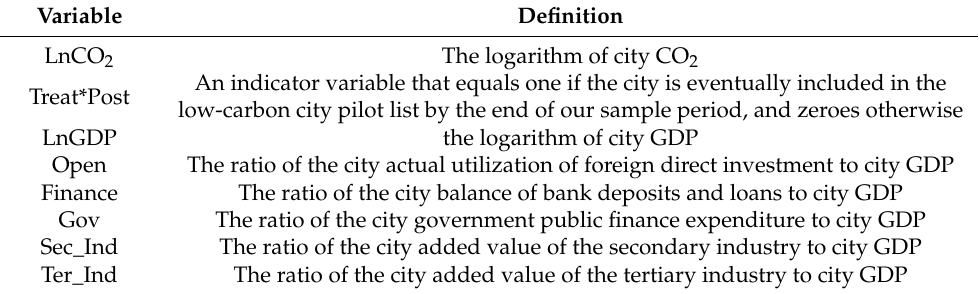
Table 1. Variables Definition.